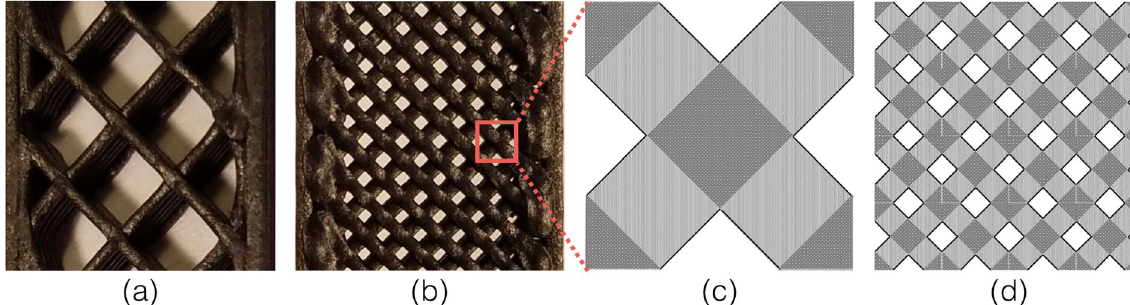
Figure 1. Internal structures of the composites showing infill% of ( a ) 20% and ( b ) 80%; ( c ) a representative volume element composed of rectilinear beads, and ( d ) simulated 80% infill structure representing the experimental infill structure in ( b